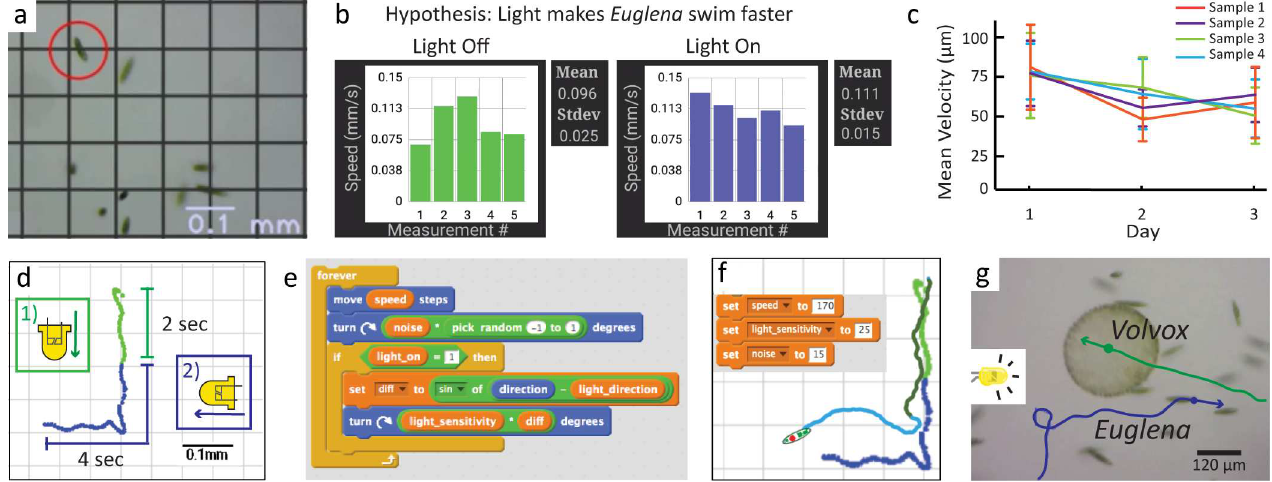
Fig 4. INQUIRE:The LudusScope enablesscientificinquiryvia quantitativehypothesis testing,measurement,and modeling. ( A ) Free- play exploration interface emphasizes learningwith grid overlay. ( B ) Screenshot of app in which the user quantitatively tests hypotheses of whether Euglena cells swim faster underdifferentconditions(S8 Video).Elementsof the screenshothave been rearranged for illustrative purposes.In this case, the experimentsdo not supportthis hypothesis, as the differences between the meanare well withinthe standarddeviation and standarderrorof mean (not shown). ( C ) With the same app, speed can be tracked over multipledays. In this example, four isolated populationswere tracked for threedays. The errorbars are standarddeviation, and show the largevariabilityin Euglena speeds. ( D ) Another applicationallows the user to select individual Euglena and display their swimming traces; the blue and green portionsrepresent the timebefore and aftera change in light stimuli (S5 Video).( E ) Models(simulations) of Euglena behavior in response to light are programmed in Scratch. The code portiondisplayed containsall relevant governingequations;the model parameters (orange)are speed,turningsensitivity to light,and noisiness of swimming path.( F ) Euglenagame emulationscan be programmedand model parameterscan be tuned to match the behavior of real Euglena (S6 Video).( G )Co-culturing Volvox (green)and Euglena (blue) demonstrates oppositephototacticresponseto light (S9 Video).